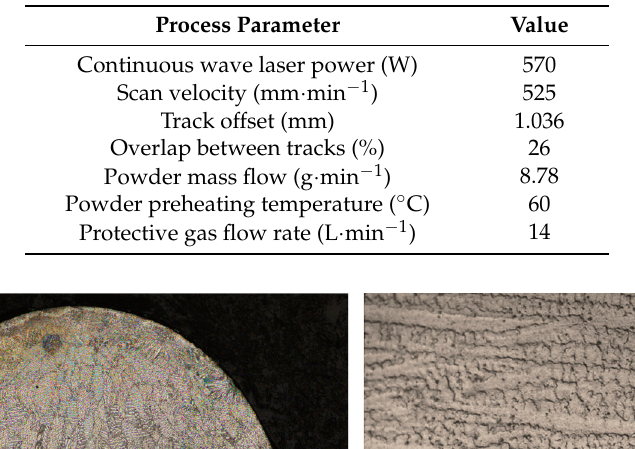
Table 2. LMD process parameters for the MetcoClad 718 [21].